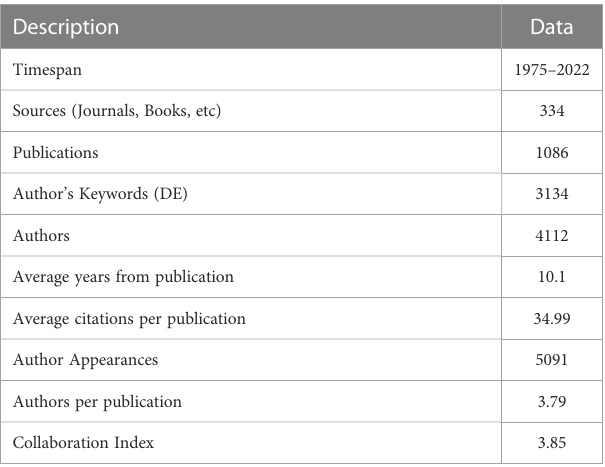
TABLE 1 Main information in relation to root plasticity during drought and recovery